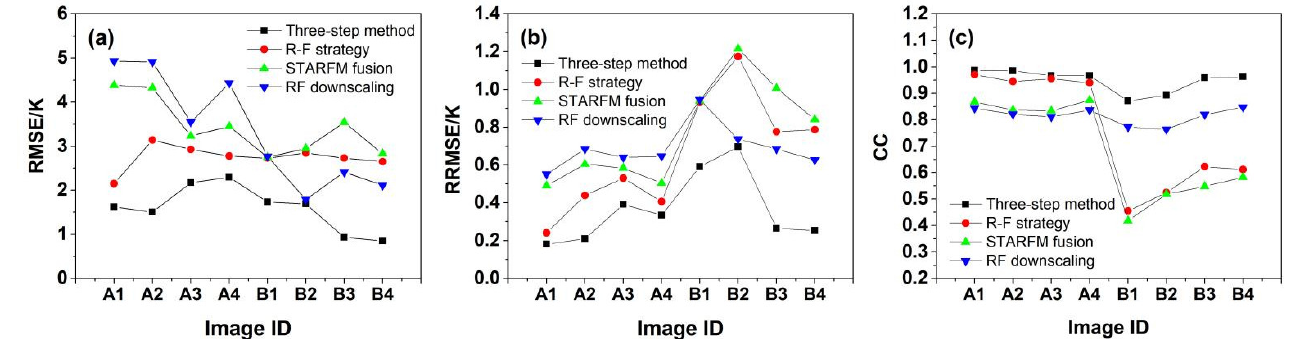
Figure 7. Accuracy comparisons of four kinds of LST prediction methods: ( a ) RMSE, ( b ) RRMSE, and ( c ) CC.